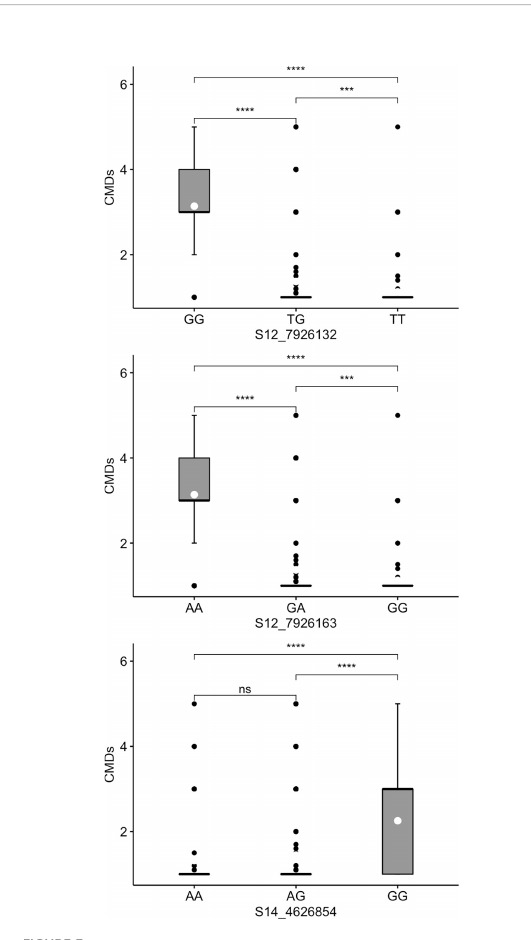
FIGURE 3 Box plots showing co-segregation of three KASP markers with cassava mosaic disease severity (CMDs). ****, *** signi fi cant at p ≤ 0.0001, p ≤ 0.001 and p ≤ 0.01, respectively; ns = non-signi fi cant.